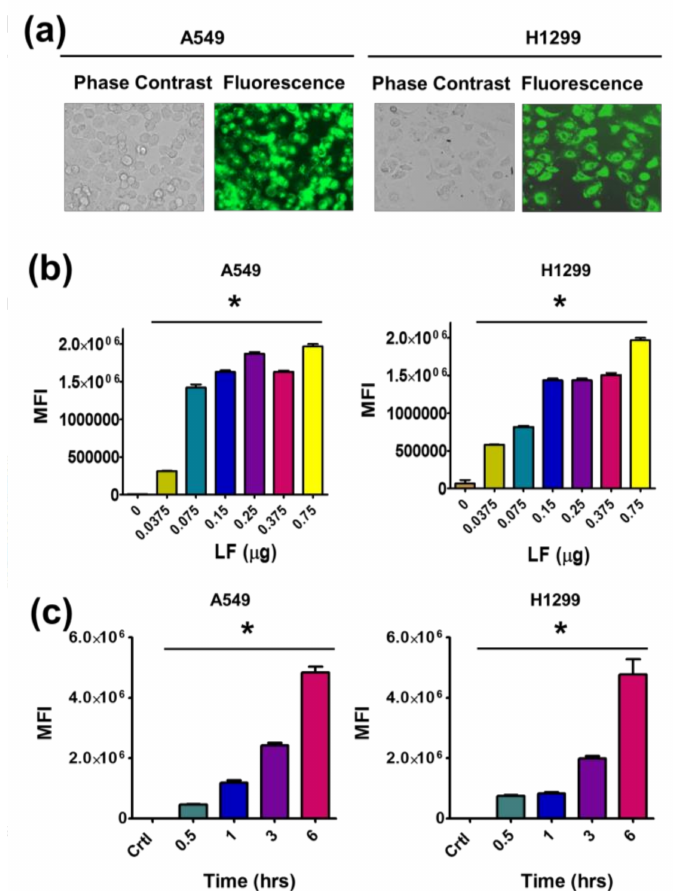
Figure 4. LF corona promotes cellular uptake of TA-LF complexes. ( a ) Cellular uptake of dye labeled TA-LF in A549 and H1299 cells. Cells were treated with coumarin-6 labeled TA-LF (5 µ g coumarin-6 equivalent) for 3 h. Representative fluorescence image was presented. ( b ) LF corona on TA exhibited enhanced cellular uptake in A549 and H1299 cells. Coumarin-6 concentration in TA-LF was 5 µ g/mL and incubation time was 3 h. ( c ) Time-dependent cellular uptake of coumarin-6 labeled TA-LF complexes. ( b , c ) FL levels of internalized coumarin-6 labeled TA-LF complexes were measured using an Accuri C6 Flow Cytometer in the FL1 channel. Data presented as mean ± SEM ( n = 3). Uptake is significance compared to no LF or control cells (* p <